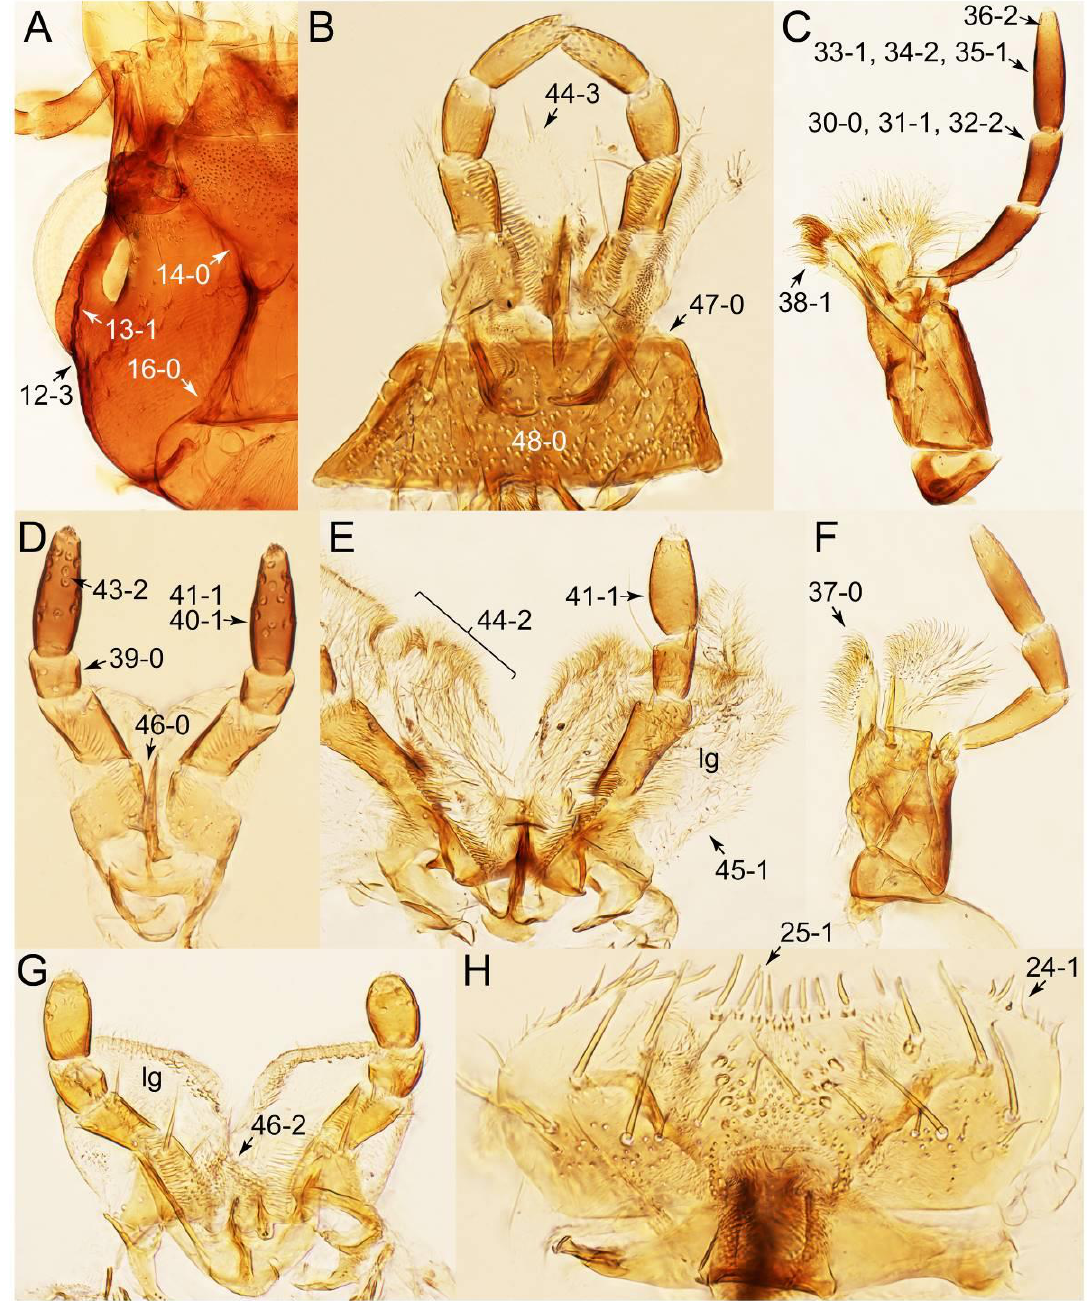
Figure 53. Photographs of body parts of Tachinusini, enlarged. ( A ) head of Leucotachinus luteonitens , ventral view. ( B ) labium and mentum of Leucotachinus luteonitens , dorsal view. ( C ) left maxilla of Olophrinus cf. philippinus , ventral view. ( D ) labium of Nitidotachinus tachyporoides , ventral view. ( E ) labium of Olophrinus cf. philippinus , ventral view. ( F ) left maxilla of Tachinus rufipes , ventral view. ( G ) labium of Tachinomorphus grossulus , ventral view. ( H ) labrum of L . luteonitens , dorsal view. Abbreviation: lg, ligula. Characters and character states (format X-X) are indicated on each